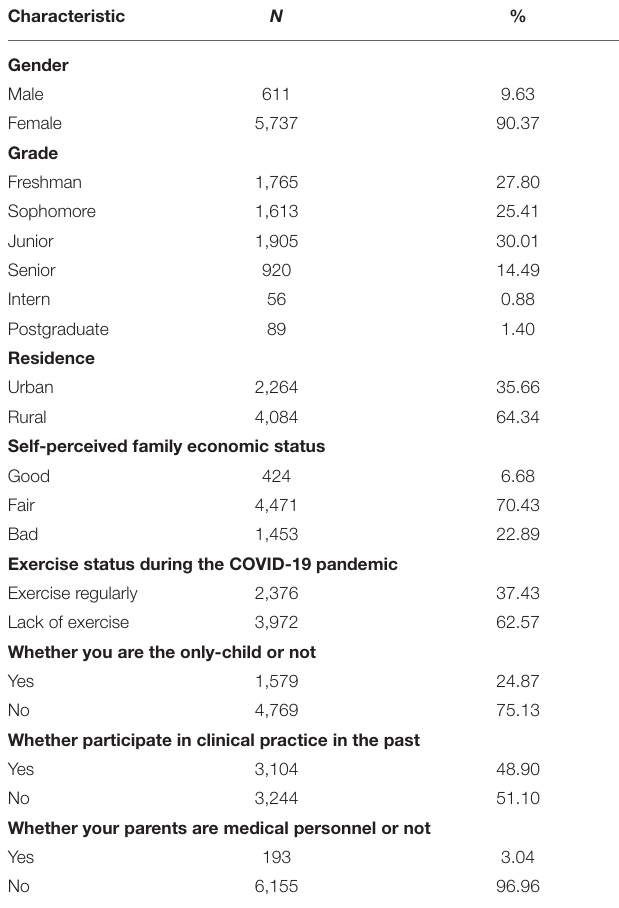
TABLE 1 | Sociodemographic characteristics of